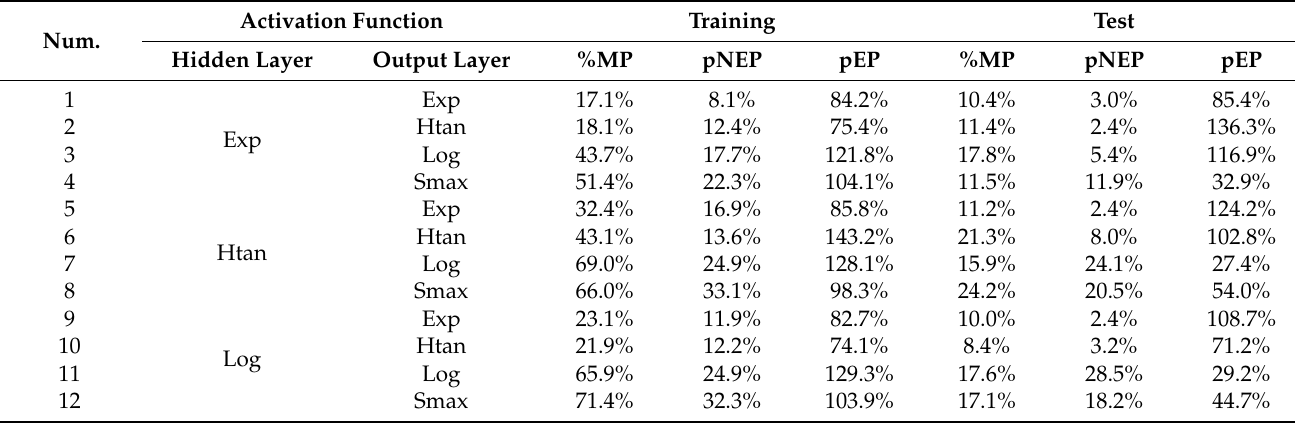
Table 2. The values of %MP, pNEP and pEP indicators, depending on the type of activation function in the hidden layer and the output layer for the number of neurons in the range from 5 to 30.